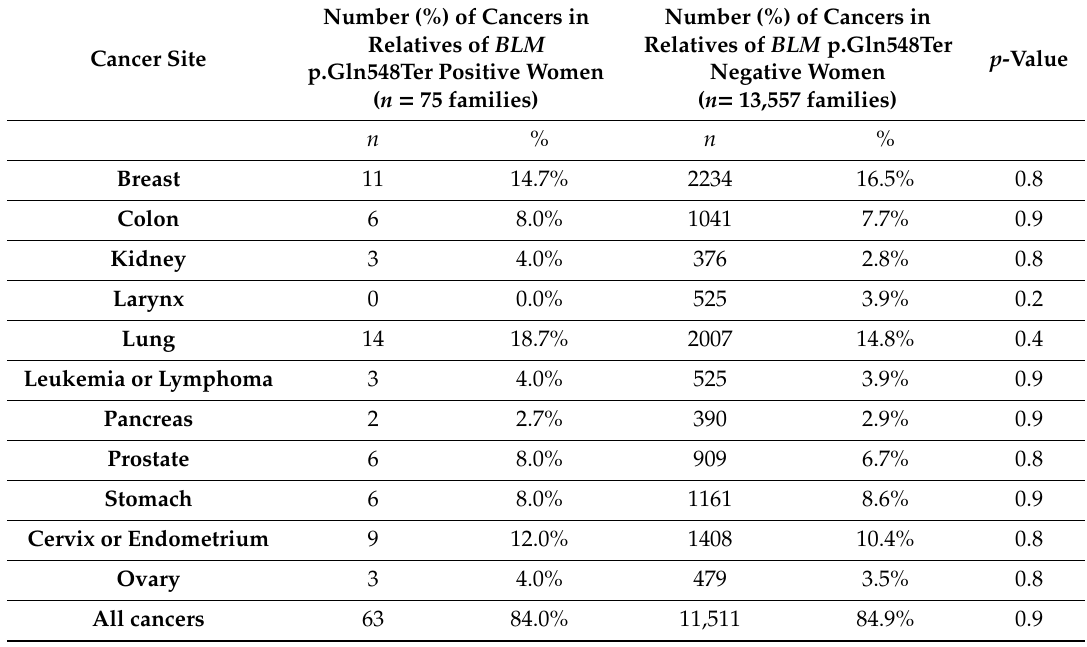
Table 3. Cancers reported in the families of the 75 unselected breast cancer cases of a BLM mutation compared to those reported by the 13,557 non-carrier cases.